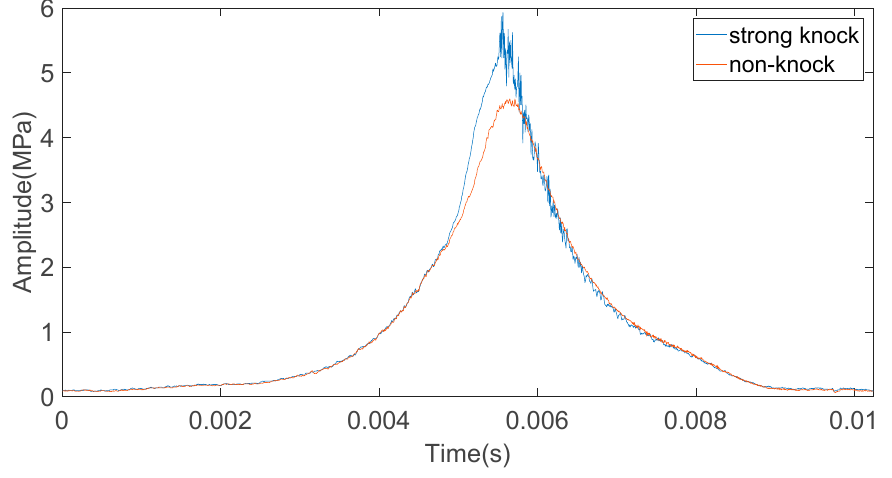
Figure 10. Curve of the cylinder pressure signal with strong knock and non-knock.